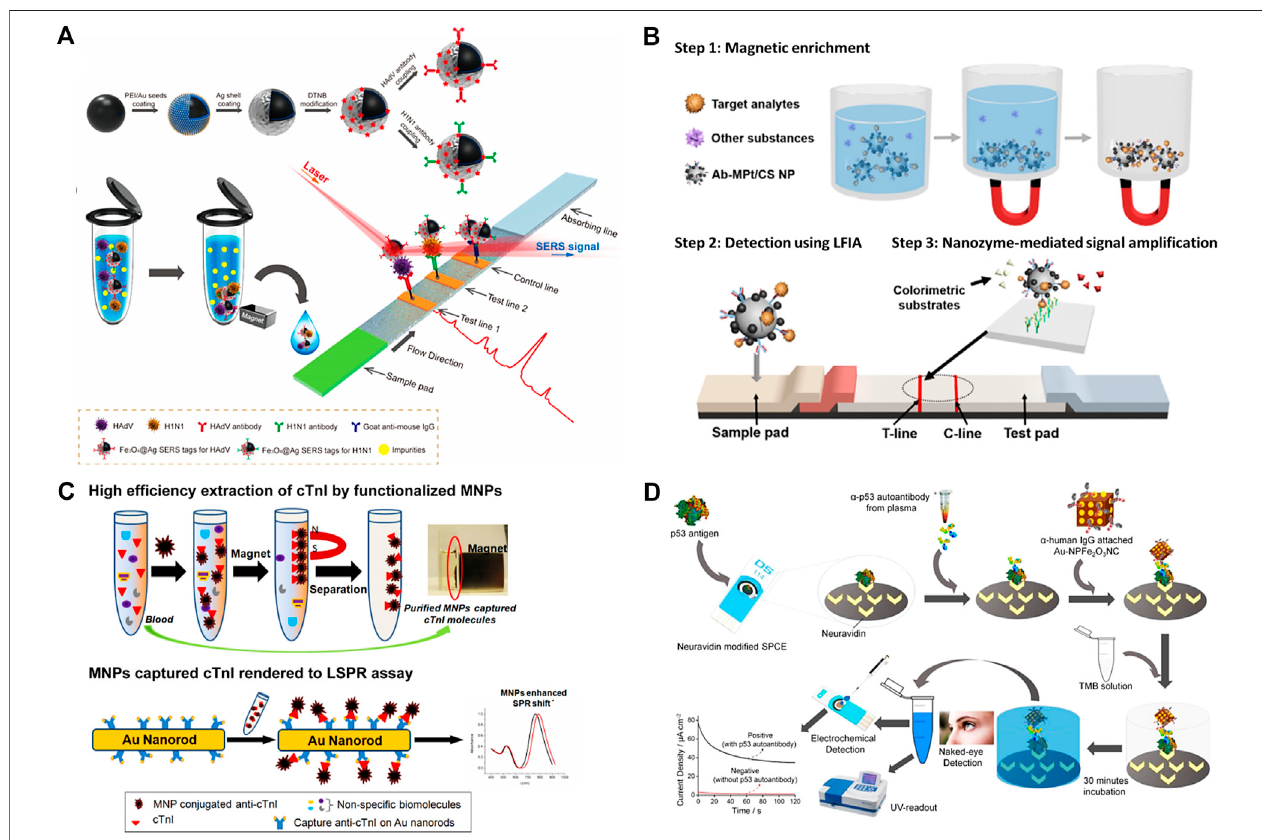
FIGURE 4 | Schematics of (A) Synthetic Route for Antibody-Modi fi ed Fe 3 O 4 @Ag Magnetic Tags and diagram of the Magnetic SERS Strip for Detecting Two Respiratory Viruses (Wang et al., 2019). Copyright 2019, American Chemical Society (B) Analyte Detection Using Magnetic Nanozyme-Based LFIA Strips (Kim et al., 2017b). Copyright 2019, American Chemical Society (C) Bio-separation of target molecules from blood plasma by functional Fe 3 O 4 magnetic nanoparticles (MNPs), followed by the MNP mediated nano-SPR assay. The application of MNP results in an enhancement of the LSPR shift at peak absorption wavelength (Tang et al., 2013). Copyright 2017, American Chemical Society (D) Assay for the detection of tumor-associated plasma (and serum) p53 autoantibody. A neutravidin-modi fi ed screen-printed carbon electrode was functionalized with biotinylated p53. Serum/plasma samples containing p53-speci fi c autoantibody were then incubated onto the electrode surface followed by the incubation with IgG/Au − NPFe 2 O 3 NC nanocatalyst. The surface-attached Au − NPFe 2 O 3 NC nanocatalyst catalyzed the oxidation of